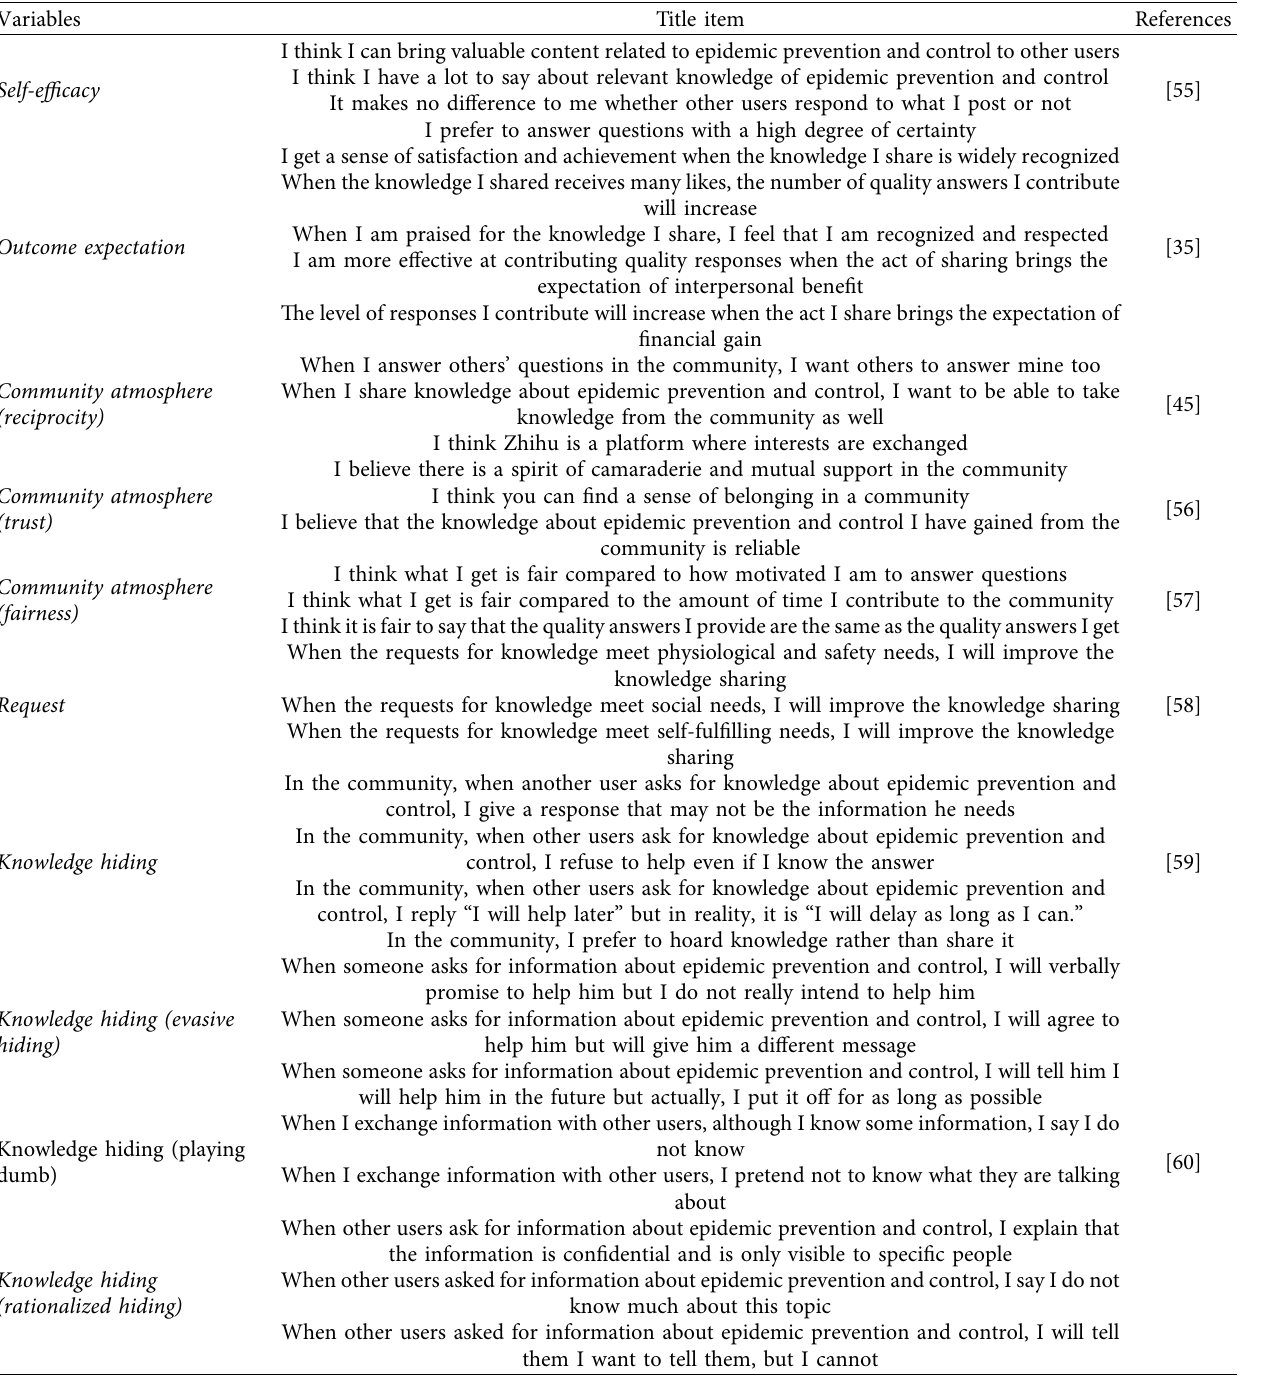
Table 1: List of questionnaire measurement